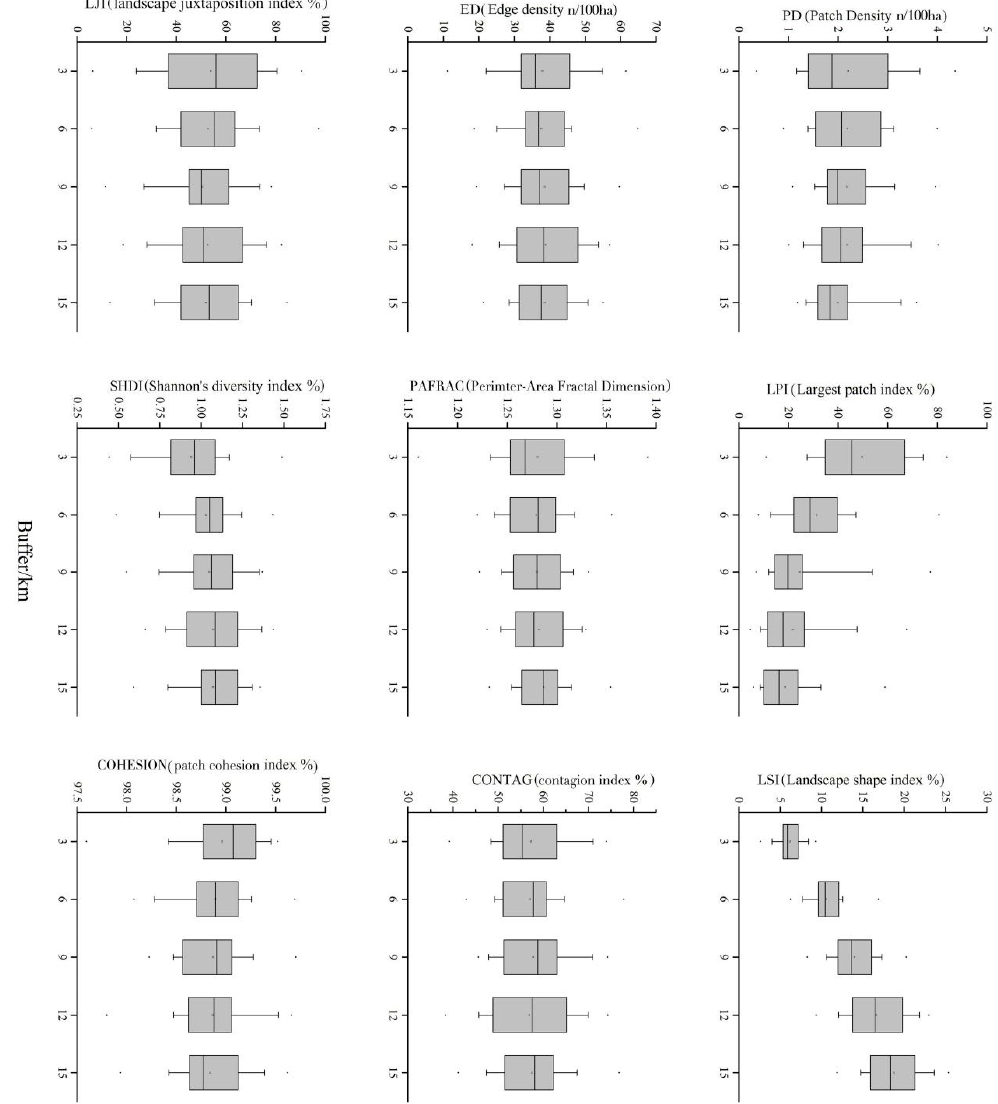
Figure 6. Landscape-level metric indices across buffer zones.